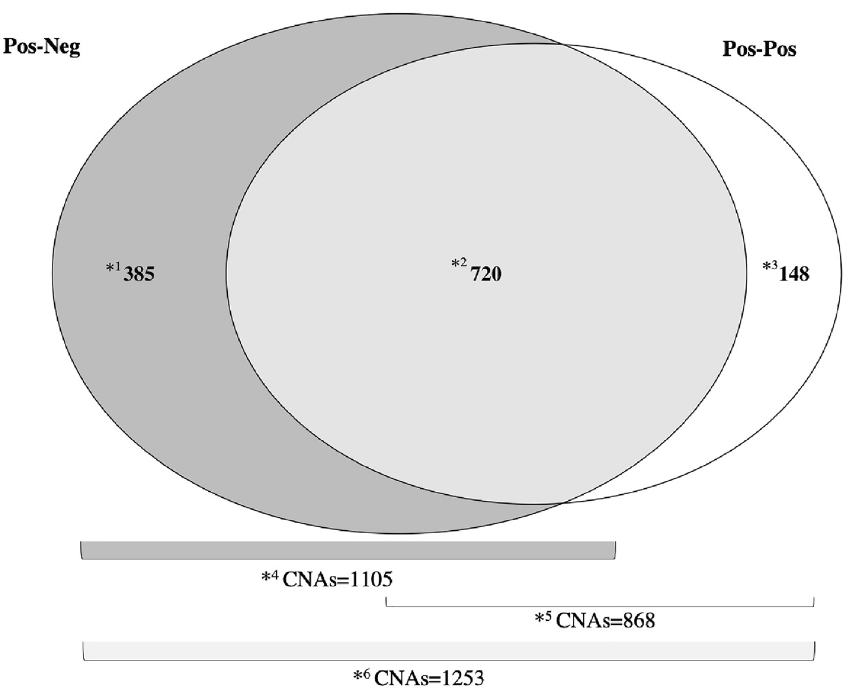
Figure 3. Diagram of the CNAs distribution in study groups. CNAs: Copy Number Alterations. * 1 : Exclusive CNAs detected in Pos-neg. * 2 : Shared CNAs between Pos-neg and Pos-pos. * 3 : Exclusive CNAs detected in Pos-pos. * 4 : Total CNAs for Pos-neg. * 5 : Total CNAs for Pos-pos. * 6 : Total CNAs detected in the study cohort (Pos-neg and Pos-pos). Pos-Neg: Positive–negative subjects; Pos-Pos: Positive-positive